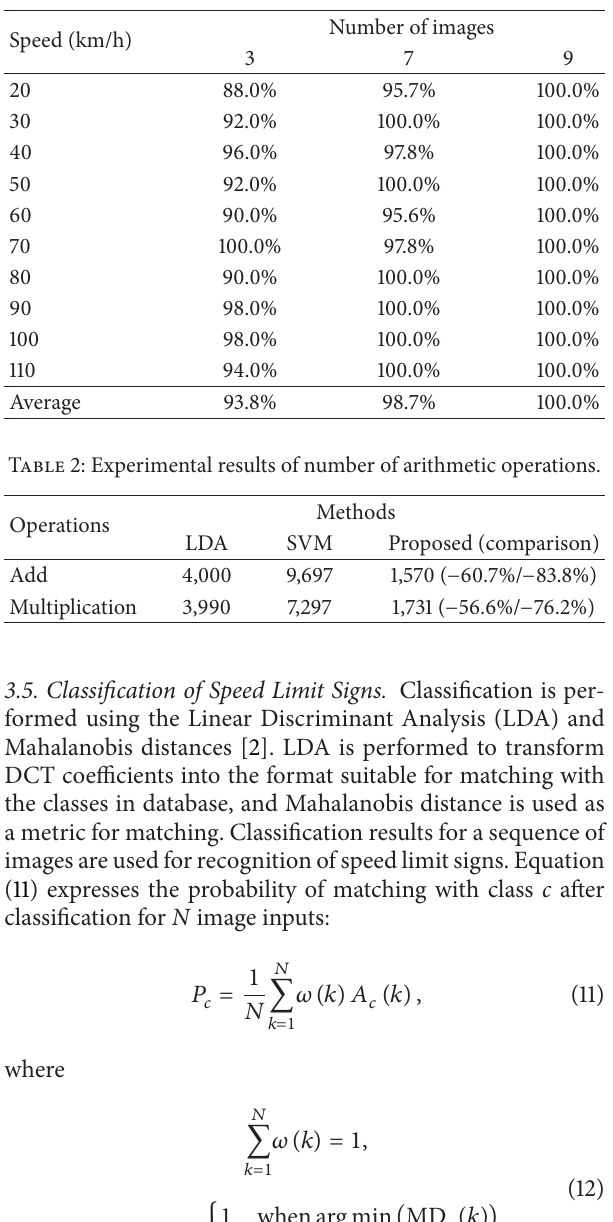
Table 1: Experimental results of hit rates of recognition.